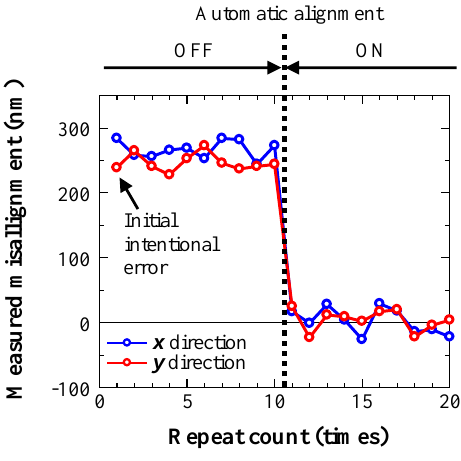
Figure 6. Action of automatic error detection and positional correction.